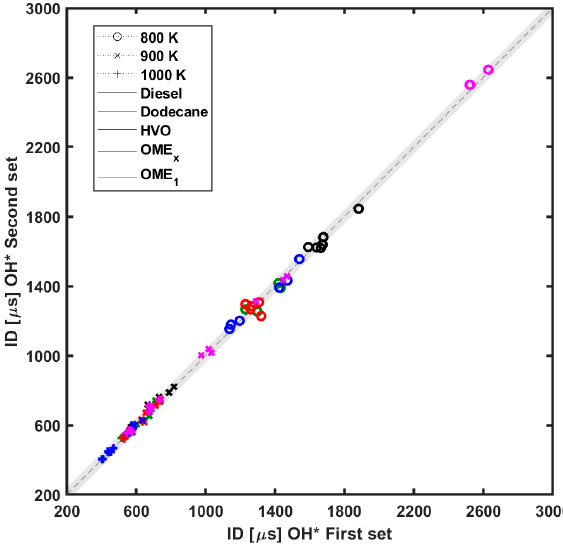
Figure 11. Comparison of ignition delay (ID) obtained in the first set and in the second one.